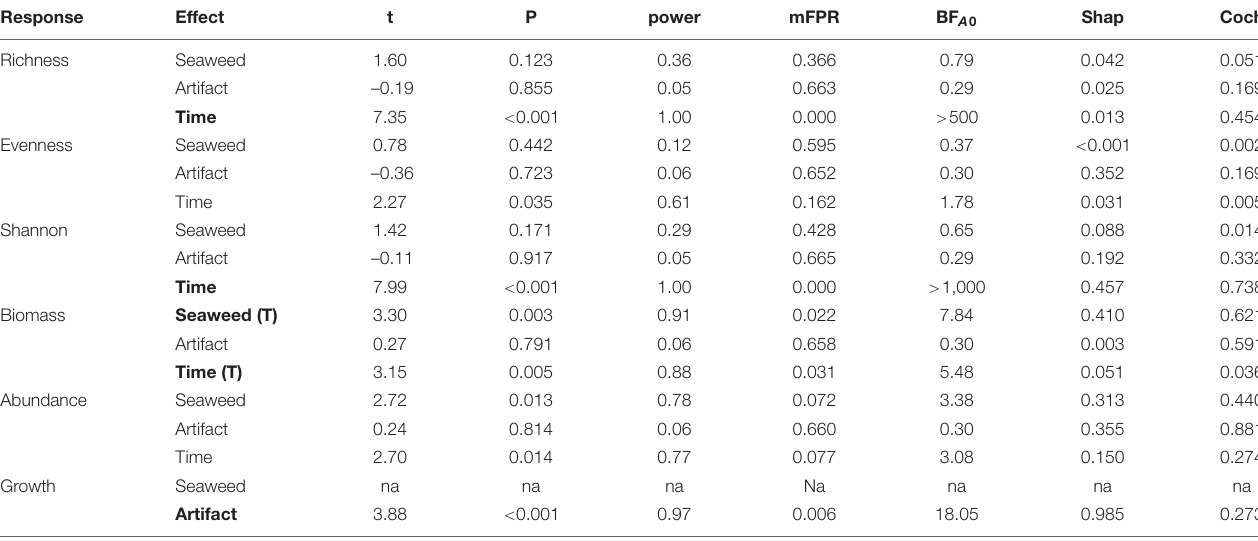
TABLE 2 | Longyearbyen.